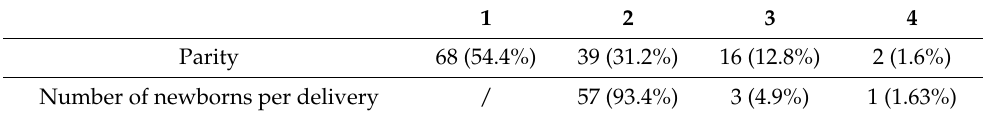
Table 2. Parity and n ◦ twins.